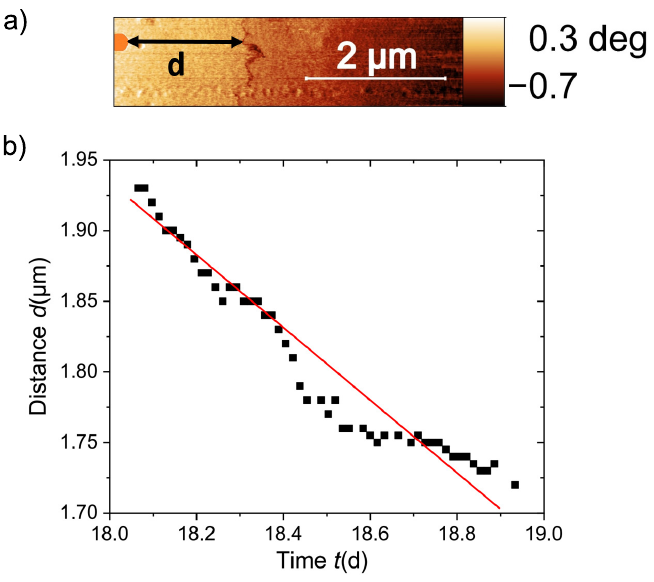
Figure 8. ( a ) Definition of the distance d between the reference topography point (orange disc at the left of the image) and the position of the current path delimited by the dark meander-like line. ( b ) Distance d vs. logarithm of time within a period of ≈ 24 h and starting the measurements 18 days after removing the applied field. The continuous line is the fit to Equation